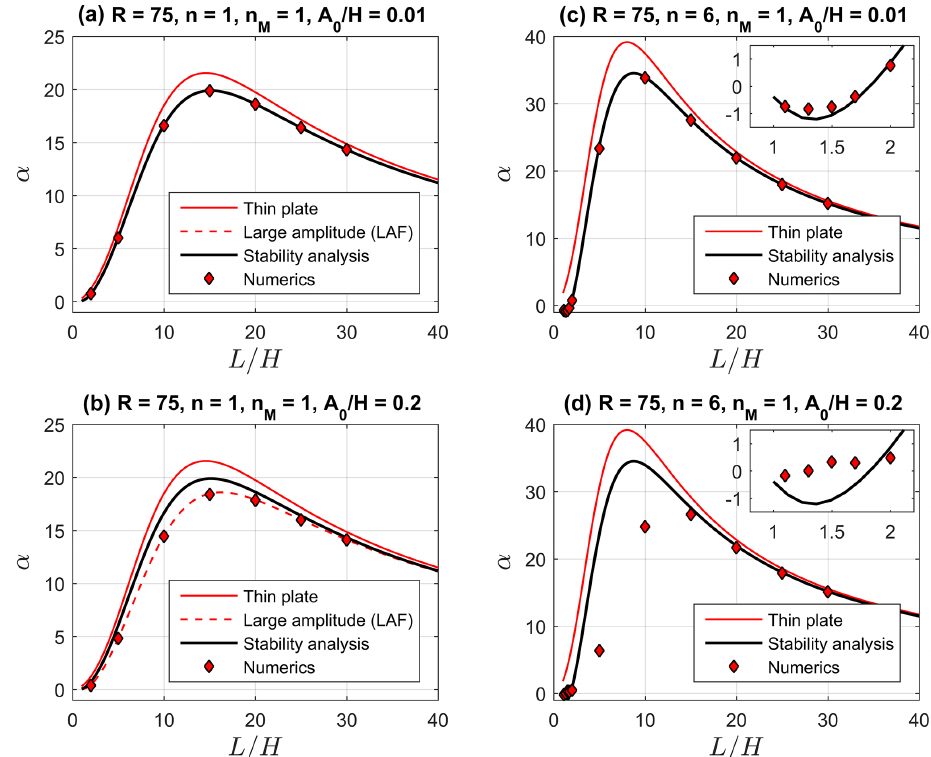
Figure 13. Dimensionless amplification rate, α , vs. wavelength to thickness ratio, L/H . All results have been calculated with the software Folder (Adamuszek et al., 2016) including the numerical results of finite element simulations indicated with red diamond symbols. (a) Layer and matrix are linear viscous (power-law exponent of layer and matrix n , n M = 1), the viscosity ratio R = 75 and the initial ratio of amplitude to layer thickness A 0 /H = 0.01. For such small initial amplitudes, the large amplitude folding (LAF) solution of Adamuszek et al. (2013b) is identical to the stability analysis. (b) like (a) but with A 0 /H = 0.02. For linear viscous folding the LAF solution can be used to calculate the amplification rate for large amplitudes. (c) Layer is power-law viscous and matrix is linear viscous ( n = 6 and n M = 1), the viscosity ratio R = 75 and the initial ratio of amplitude to layer thickness A 0 /H = 0.01. (d) like (c) but with A 0 /H = 0.02. In (c) and (d) the insets in the top right show enlargements of the region with small values of L/H .